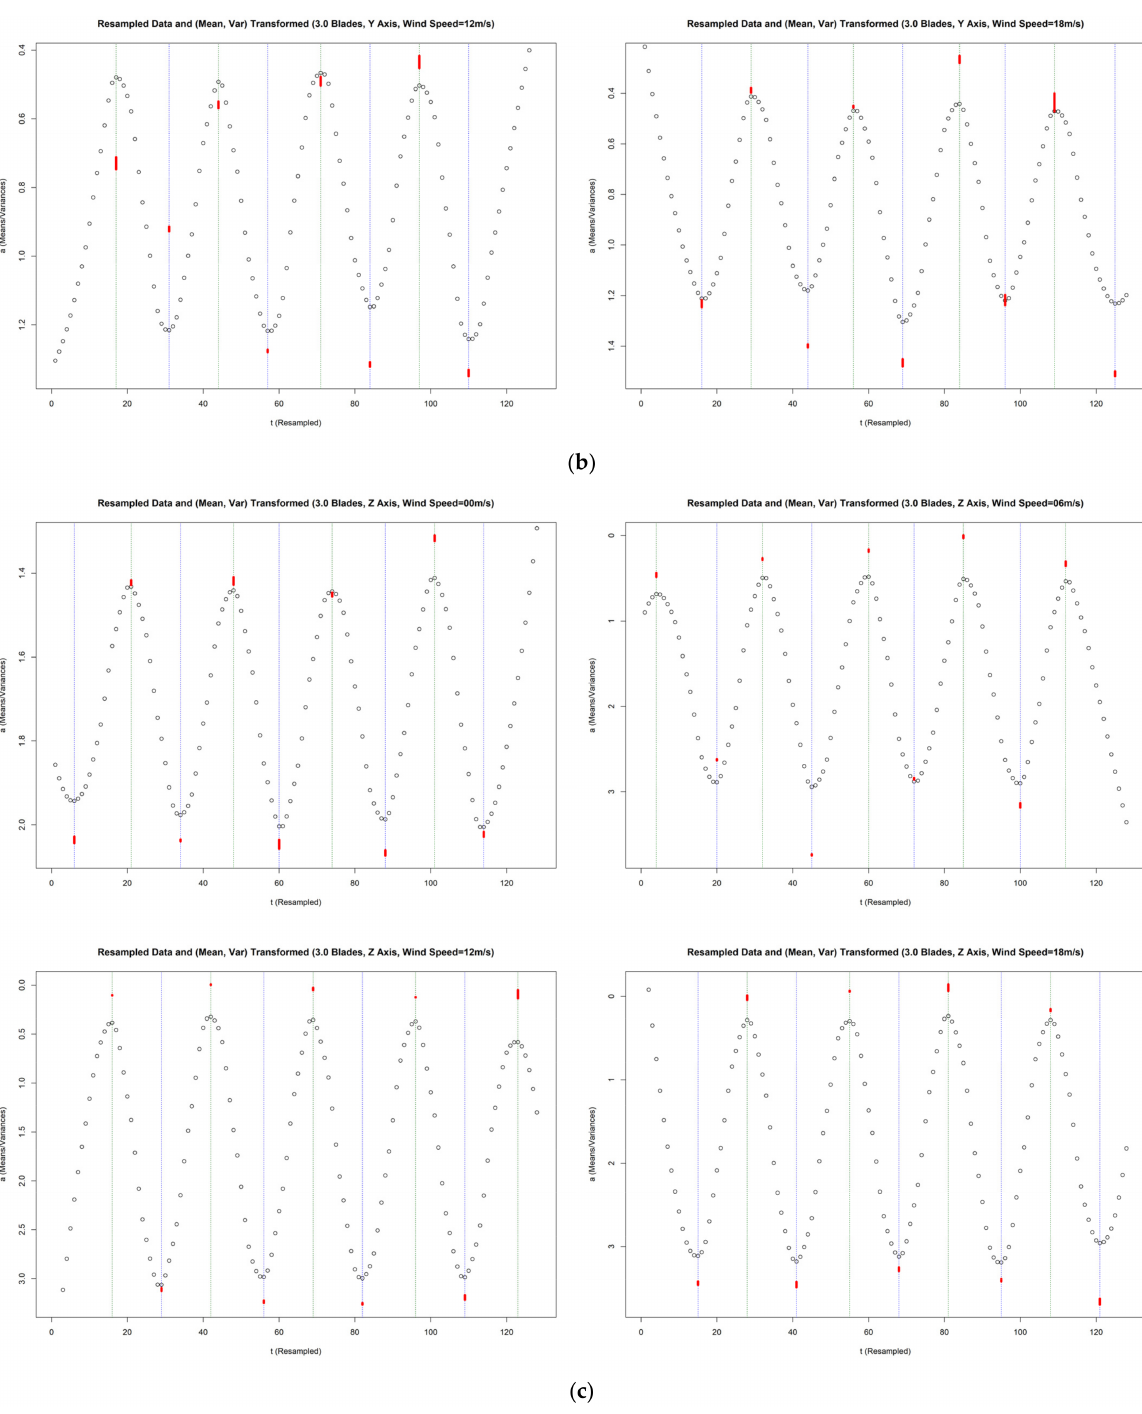
Figure A7. Means and peak/valley variances of resampled data for the 3.0-blade turbine. ( a ) Based on datasets recorded along the X axis with different wind-speeds imposed. ( b ) Based on datasets recorded along the Y axis with different wind-speeds imposed. ( c ) Based on datasets recorded along the Z axis with different wind-speeds